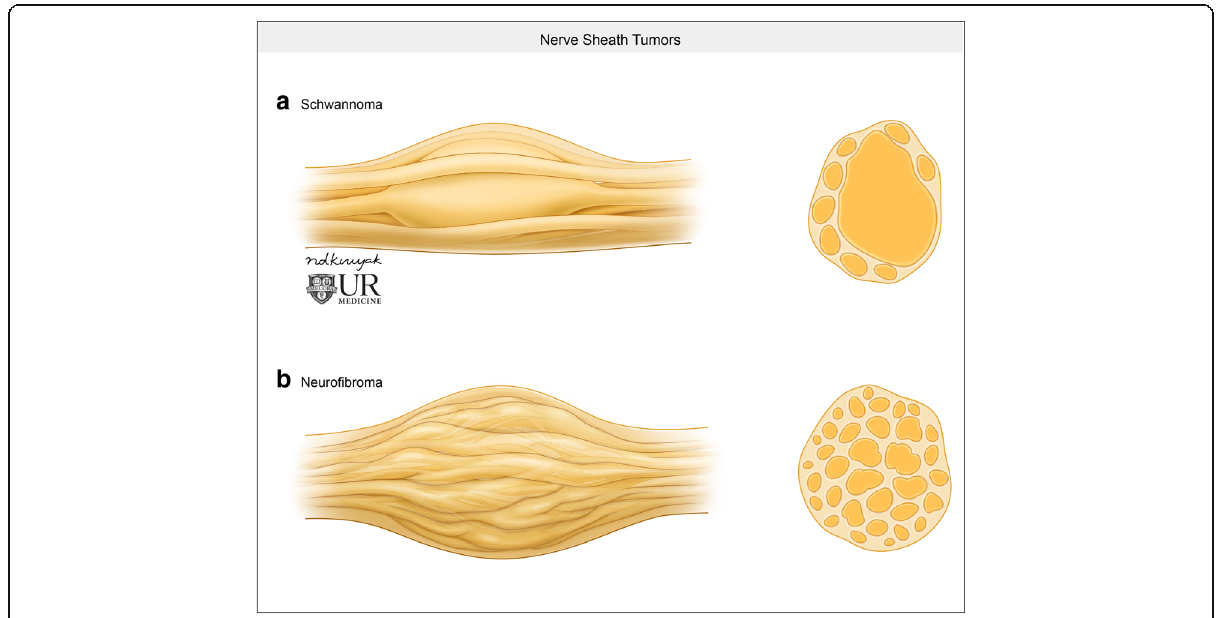
Fig. 6 Nerve sheath tumors. a Illustration demonstrating the relatively eccentric configuration of a schwannoma relative to the affected nerve. b Conversely, neurofibromas tend to be fusiform, longitudinal, and interspersed in the nerve